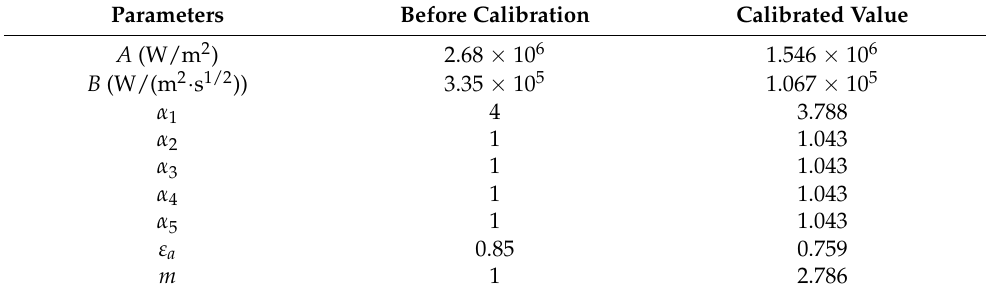
Table 7. Calibrated parameters of model.